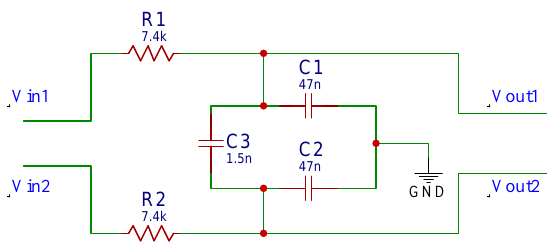
Figure 6. Schematic of the low-pass